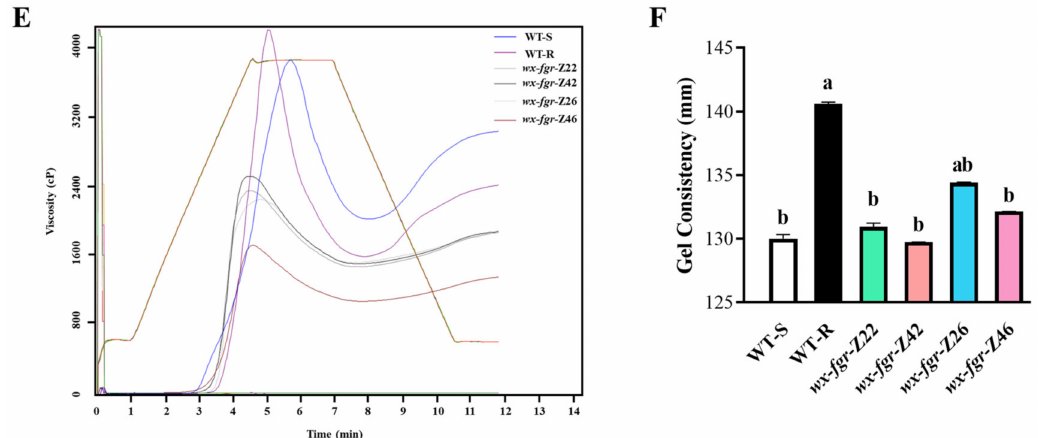
Figure 2. Creation of two-line fragrant glutinous hybrid rice. ( A ) Microscopic observation of iodine- stained endosperm. WT-S represents the wild type of sterile line ZN1S and WT-R represents the wild type of restorer line ZN1307. Scale bars, 200 µ m. ( B ) The amylose contents determined by iodine colorimetry of ZN1S, ZN1307 and the F 1 hybrid ZN1S mutants × ZN1307 mutants. ( C ) Total ion chromatograms (TIC) of 2-AP and TMP in the grains of ZN1S, ZN1307 and the F 1 hybrid ZN1S mutants × ZN1307 mutants. 2, 4, 6-trimethyl pyridine (TMP) was used as the internal standard. ( D ) 2-AP content. ( E ) Rapid visco analysis. cP (centi Poise), viscosity unit. ( F ) Gel consistency. Error bars are means ± SD ( n = 3). Samples without the same letter show significant difference by Duncan’s test ( p <